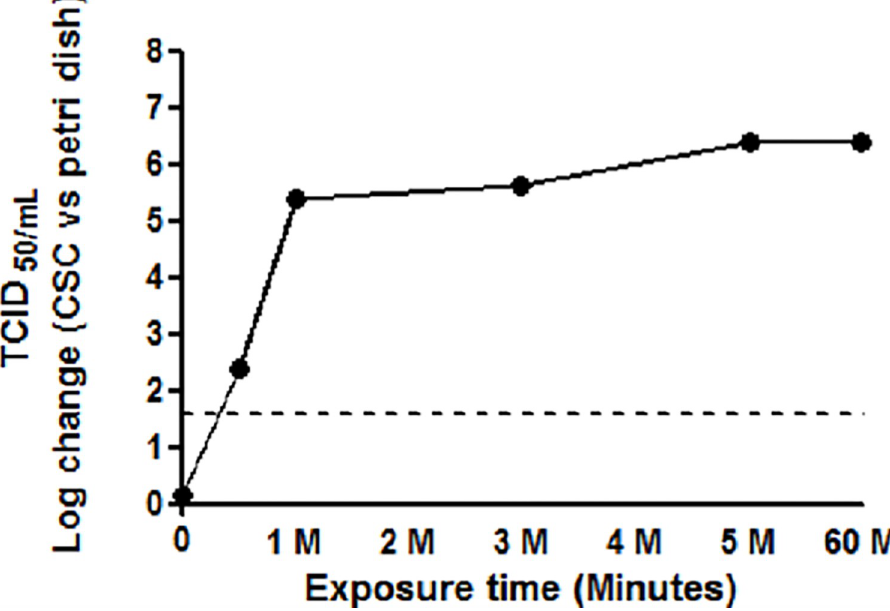
Fig 2. Effect of CSC in inactivating hCoV 229E compared to the sterile polystyrene group. The inactivation log change value was calculated by subtracting the TCID 50 value of sterile polystyrene from TCID 50 value of CSC group collected at each time point. The dotted line denotes the limit of